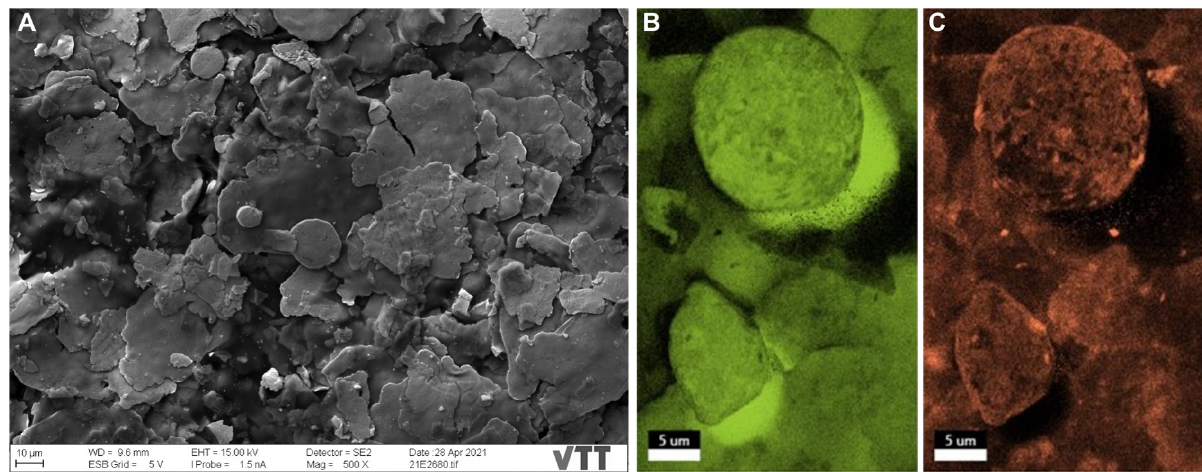
Figure 4. SEM images and EDX mapping of sample C. ( A ) SEM image of morphological irregular copper flakes. ( B ) Mapped image of morphological irregular copper flakes denoted in green. ( C ) Mapped image of some Cu particles displayed as the spherical-shaped and irregular pear-shaped particles doping irregular spherical Ag NPs denoted in orange.